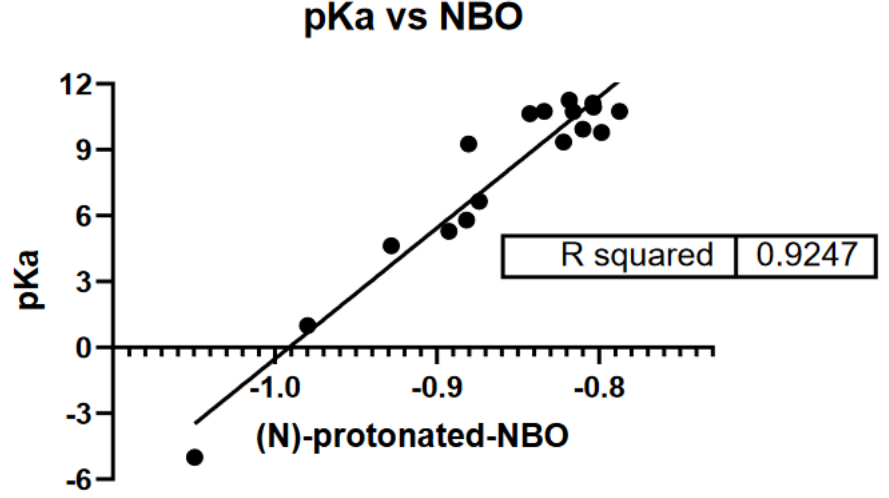
Figure 2. Protonated amines atomic charge, pKa vs. HF/321G NBO data.